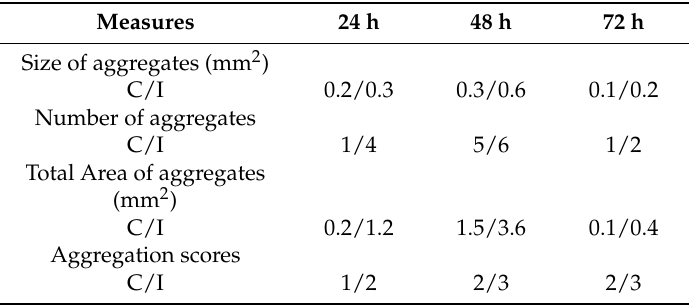
Table 1. Aggregation measures for control (C) and inoculated (I) drinking water cultures at 24, 48, and 72 h under stagnant